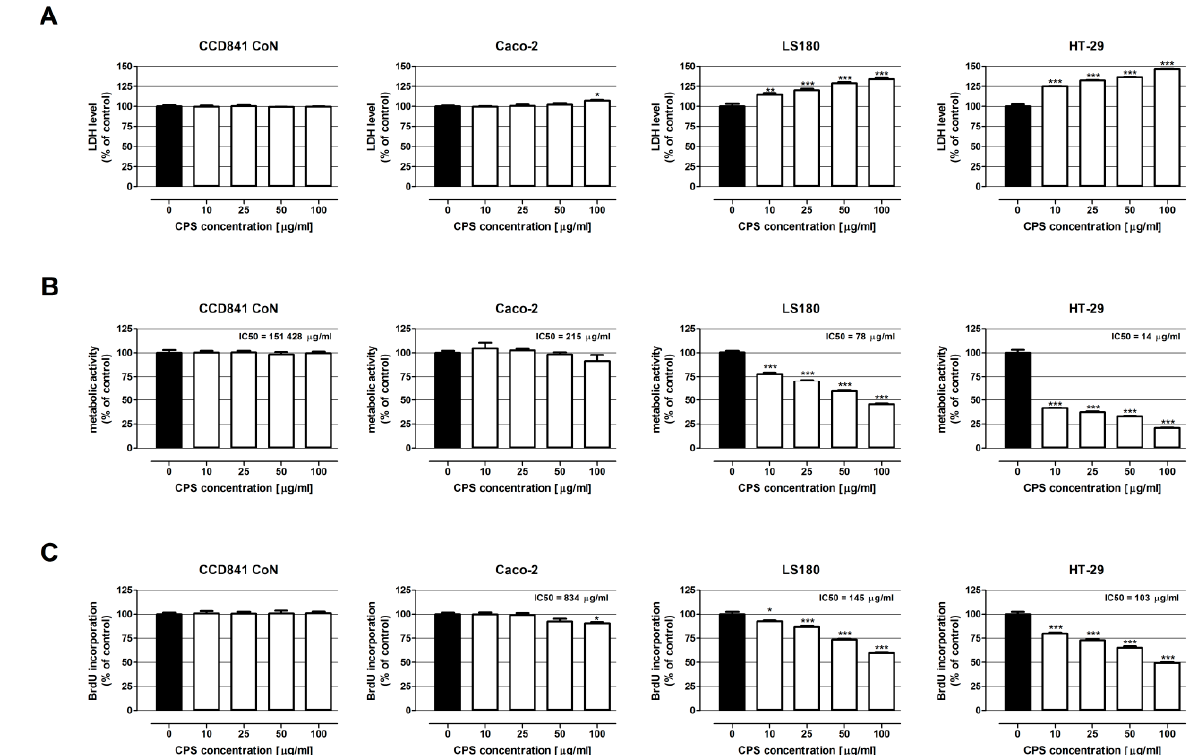
Figure 3. Antiproliferative and cytotoxic effect of crude polysaccharides isolated from S. crispa on human colon epithelial cell line CCD841 CoN and human colon adenocarcinoma cell lines: Caco-2, LS180, and HT-29. The cells were exposed to the culture medium alone (control) or the crude polysaccharides from S. crispa (CPS) at concentrations of 10, 25, 50, and 100 µg/mL for 24 h (LDH assay), for 48 h (BrdU assay) and for 96 h (MTT assay). CSP cytotoxicity was measured photometrically by means of the LDH assay ( A ), while the antiproliferative impact of CSP was examined photometrically by means of the MTT assay ( B ) and BrdU assay ( C ). Results are presented as mean ± SEM of at least 4 measurements. * p < 0.05 versus control, ** p < 0.01 versus control, *** p < 0.001 versus control, one-way ANOVA test; post-test: Tukey.